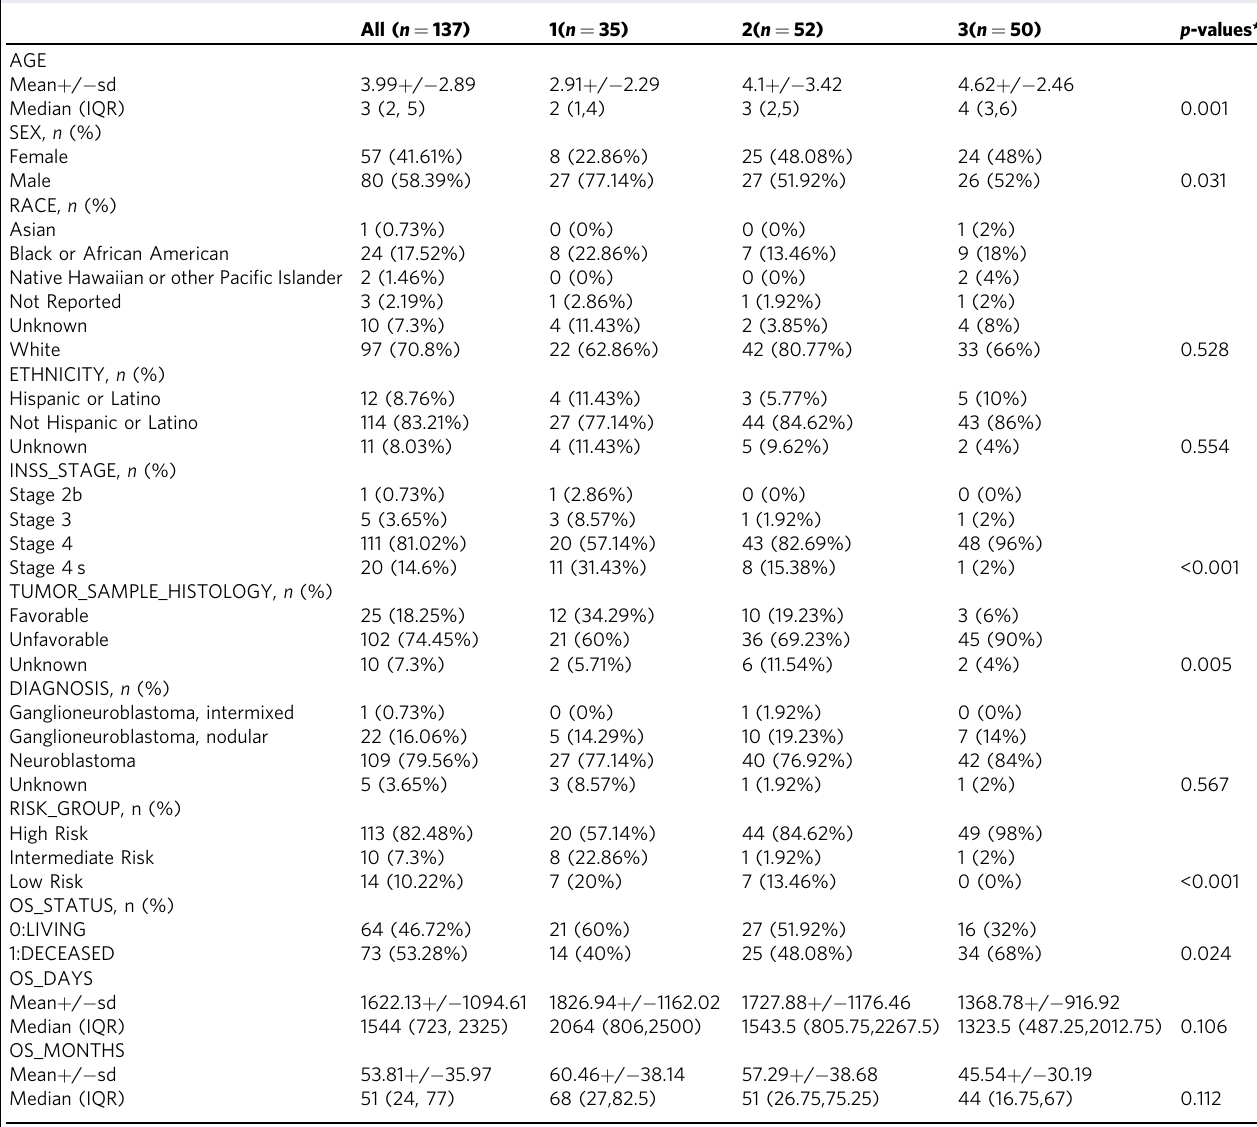
Table 1 Patient characteristics in the three gene expression